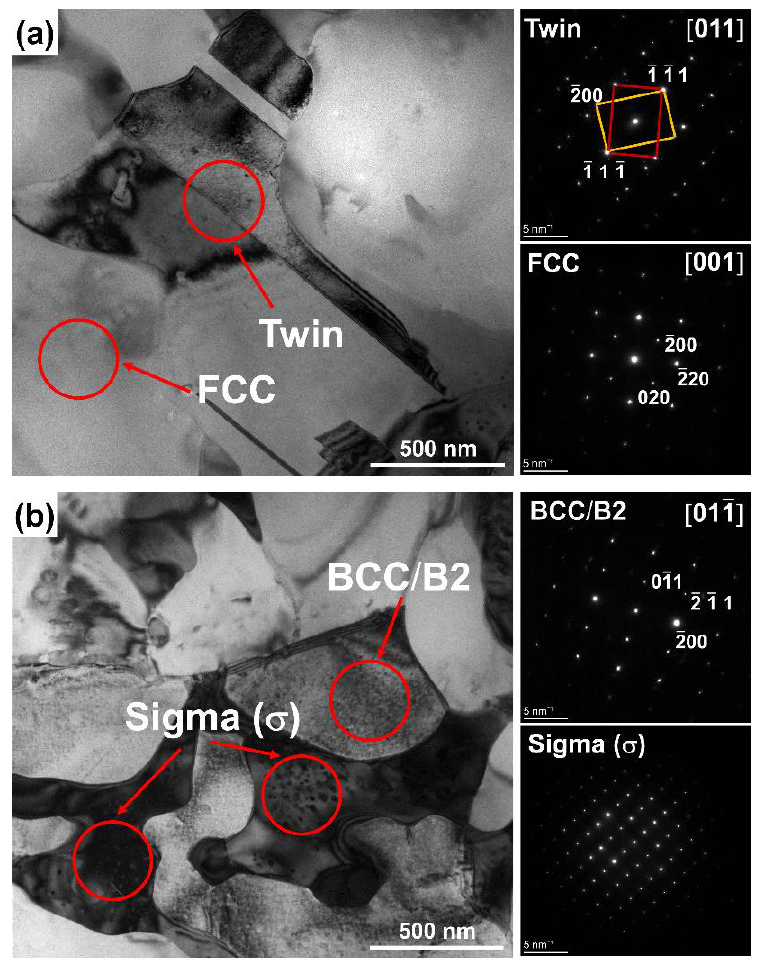
Figure 4. TEM bright-field (BF) images ( a ) and the corresponding selected area electron diffraction (SAED) patterns ( b ) of Al1 HEA.